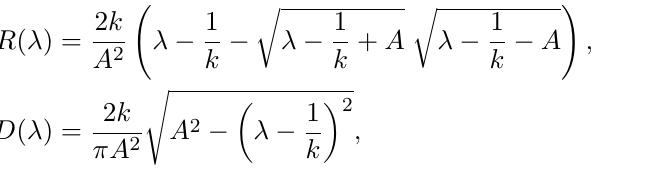
Figure 6 . Logarithmic negativity near the disconnected-to-pairwise transition with Z 2 /Z 2 e − 5 , along with the naive answers in the dominant regions: E disconnected = 0 and E pairwise = (cid:16) (cid:17) 1 log k + log Z 2 + log 8 , where log 8 is an O (1) term arising from the analytic continuation of 2 3 π 3 π Z 2 1 the Catalan number in N (even) to m = 1 / 2 2 m